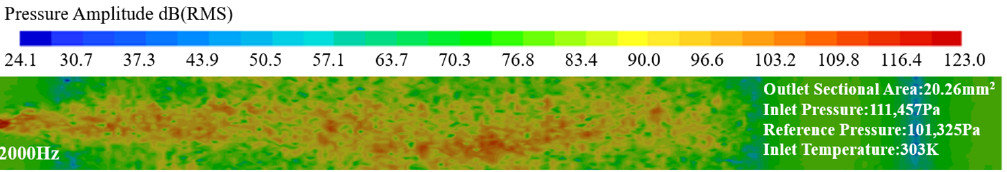
Figure 17. Cloud map of the 2000 Hz near-field sound pressure levels of the equal-diameter nozzle.